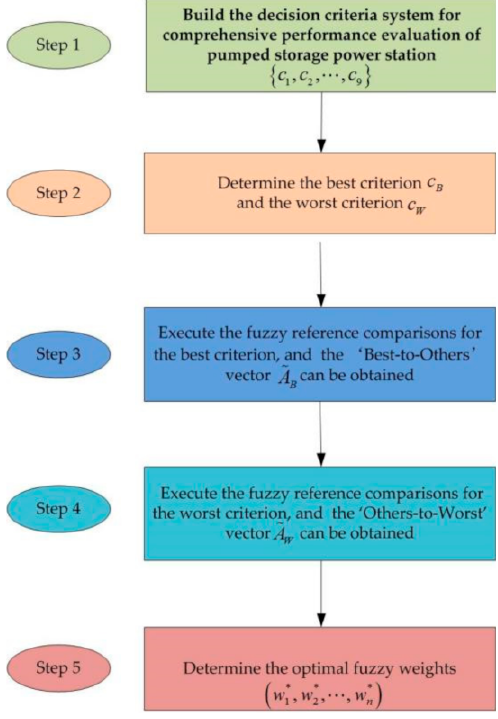
Figure 2. The detailed steps of the